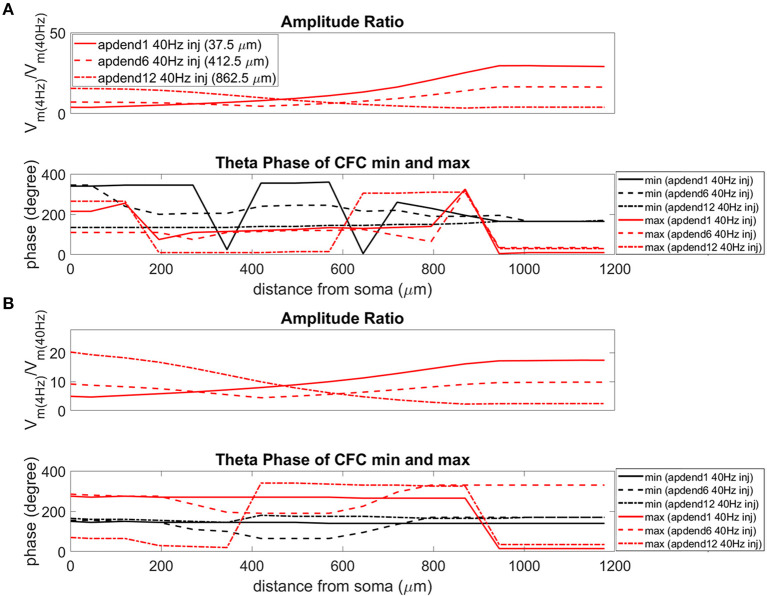
Amplitude ratio and theta phase of CFC for model with no Ih conductance. (A) Distal 4 Hz modulation, amplitude ratio (top), and theta phase (bottom) of minimum (black) and maximum (red) amplitude of 40 Hz membrane potential oscillation. Forty Hertz current injected into base of apical dendrite (solid lines), middle of apical dendrite (dashed lines), and distal apical dendrite (dot-dashed lines). (B) Perisomatic 4 Hz modulation, amplitude ratio (top), and theta phase (bottom) of minimum (black) and maximum (red) amplitude of 40 Hz membrane potential oscillation. Forty Hertz current injected into base of apical dendrite (solid lines), middle of apical dendrite (dashed lines), and distal apical dendrite (dot-dashed lines).